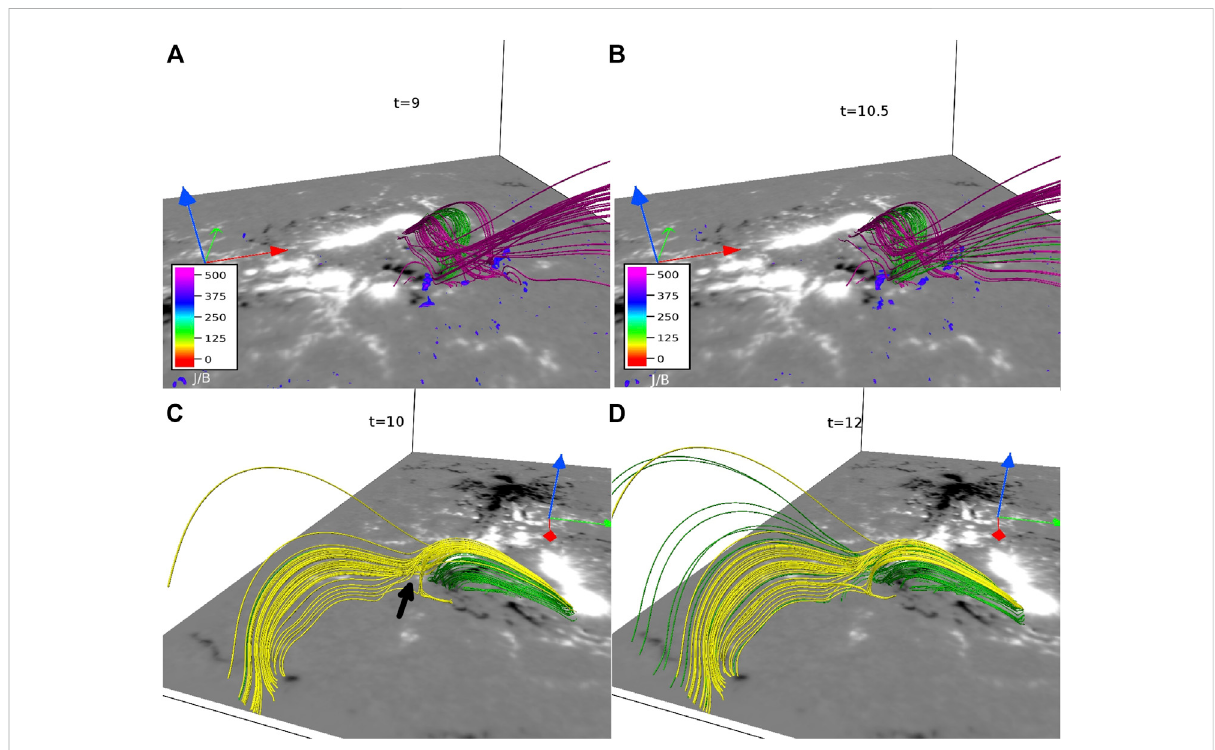
FIGURE 9 Panels (A) and (B) illustratetheevolutionofthegreen-colored rope( fi lament)and themagenta-colored ropeoverplotted with| J |/| B |.Here,the time is in units of around 1 min. Non-parallel fi eld lines of these ropes reach in the close vicinity and develop high | J |/| B | regions, which explain the onset of reconnections in green-colored rope. Panels (C) and (D) show the green-colored rope along yellow fi eld lines of the 3D null (marked by black arrow in panel (c)) at t = 10 and t = 12. Green fi eld lines appear to move toward the 3D null and get